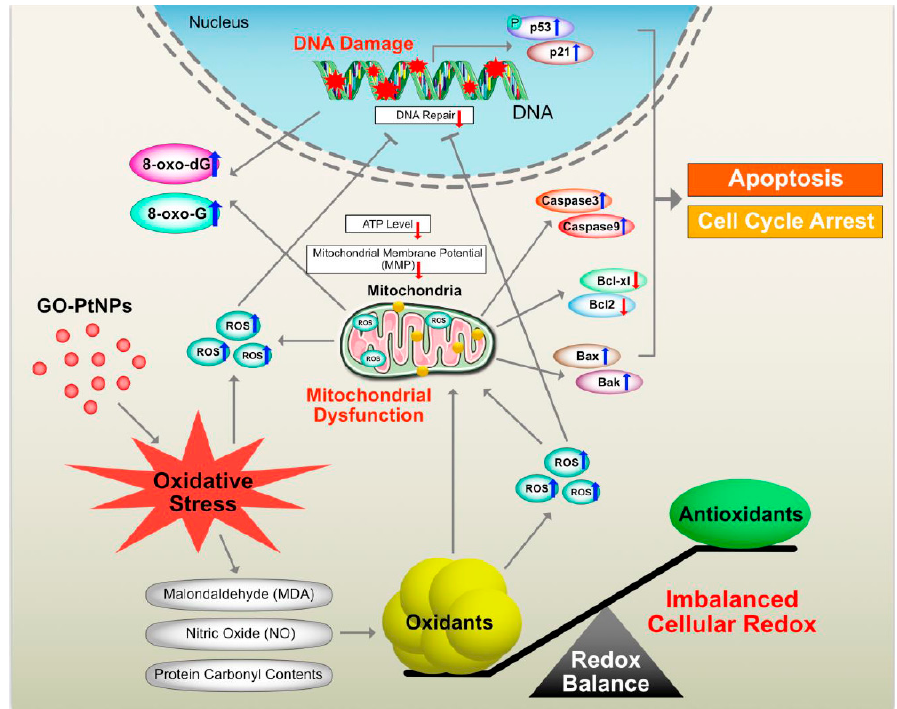
Figure 15. The hypothetical model demonstrates that the impact of GO-PtNPs on oxidative stress induced DNA damage in LnCaP